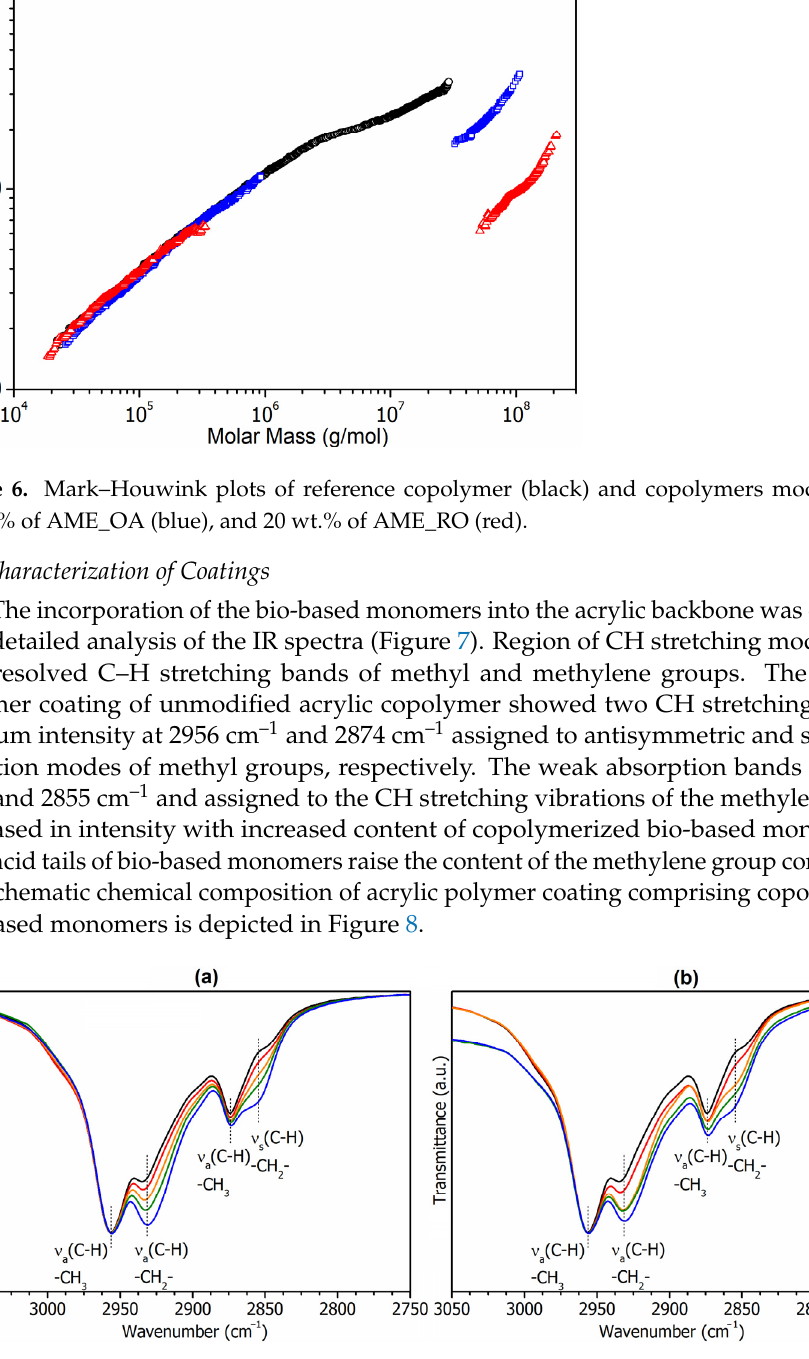
Figure 7. Detailed IR spectra of polymer coatings modified with AME_RO ( a ) and AME_OA ( b ): reference copolymer (black), 5 wt. % (red), 10 wt. % (orange), 15 wt. % (green), and 20 wt. % (blue) of the respective bio-based monomer.